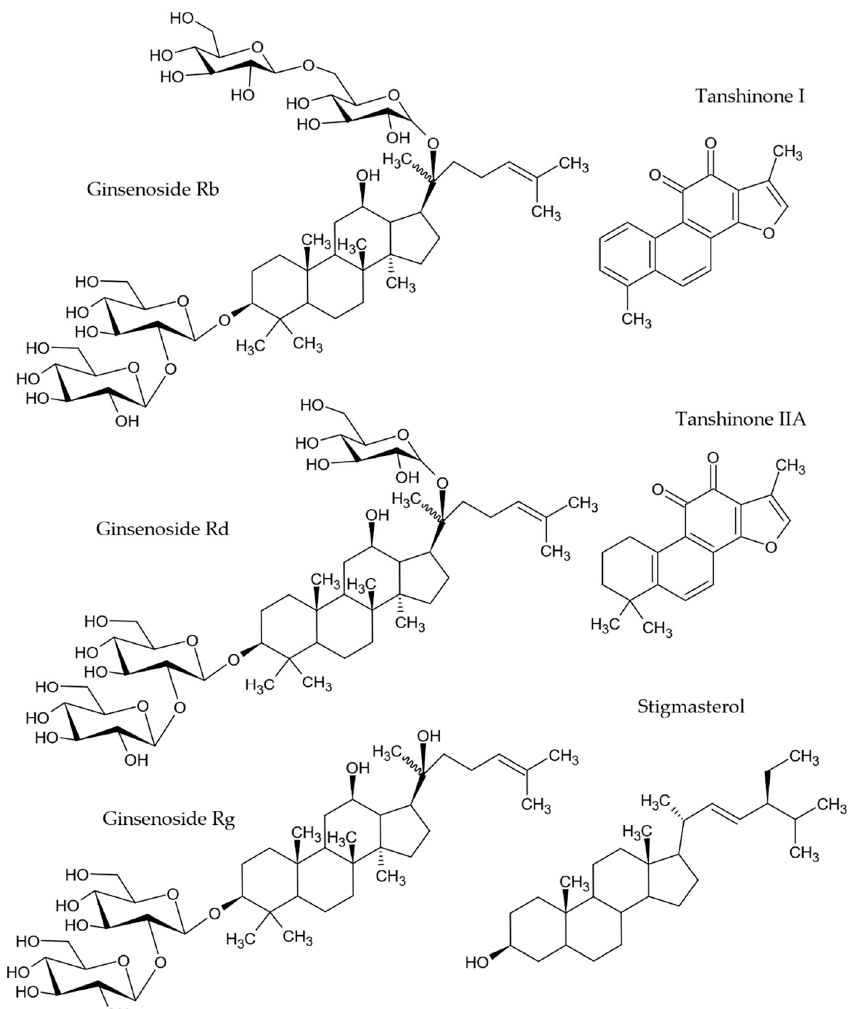
Figure 7. AntiAGEs terpenoids reported in endophytes.